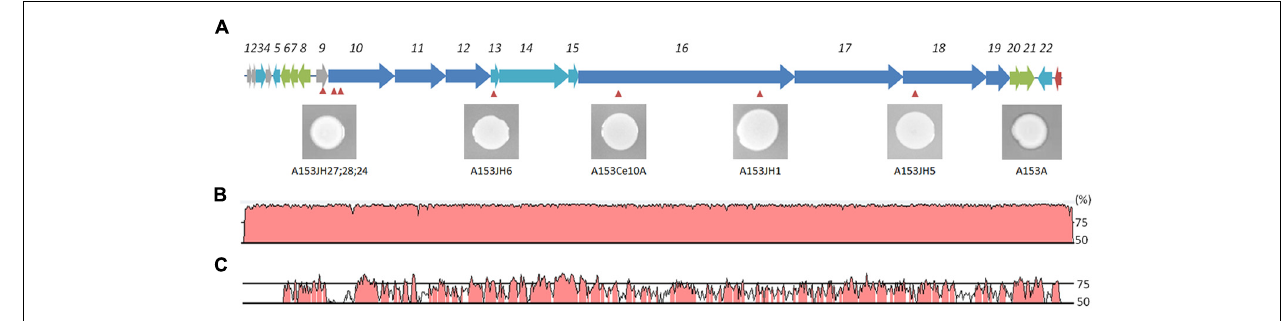
at 25 ◦ C. Note the panel depicting the phenotype of the A153 (cid:2) andR parent strain to the far right. DNA homology (%) between the zmn gene cluster of A153 and those of S. plymuthica RVH1 (B) and D. solani MK10 (C) is presented. Sequence comparisons were performed using wgVISTA and show regions of > 50%